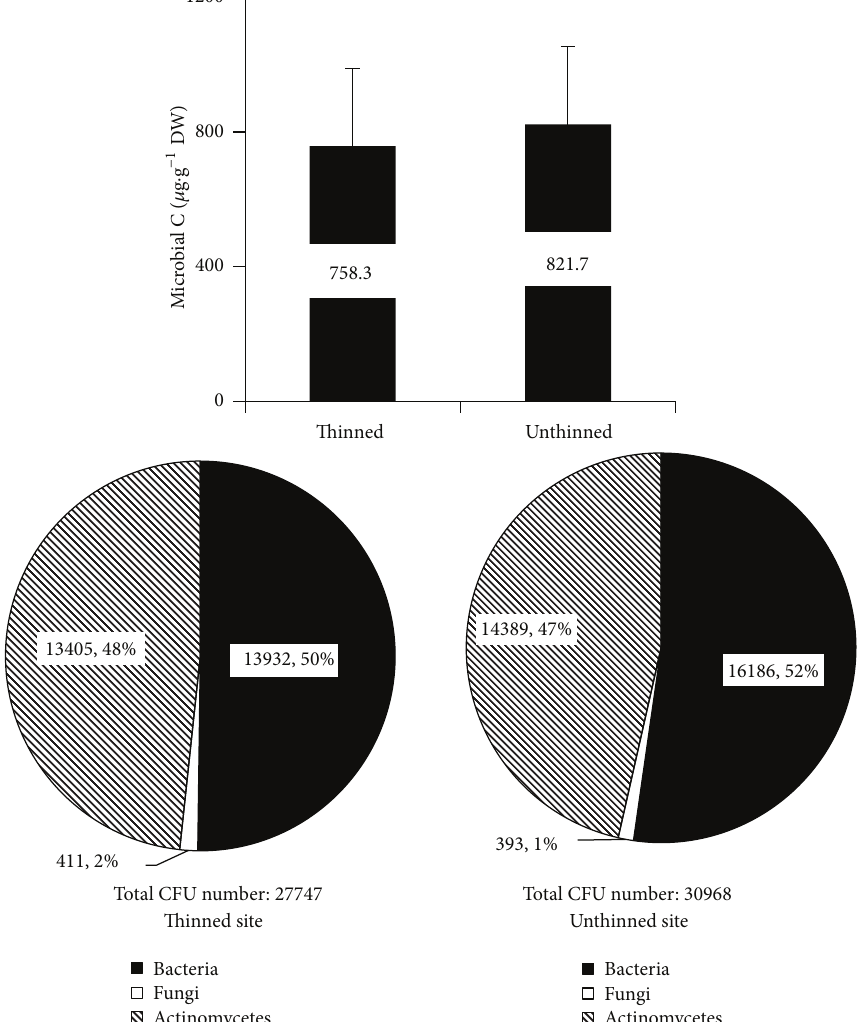
Figure 1: The effect of long-term thinning on microbial carbon and the microbial composition of bacteria, fungi, and actinomycetes.